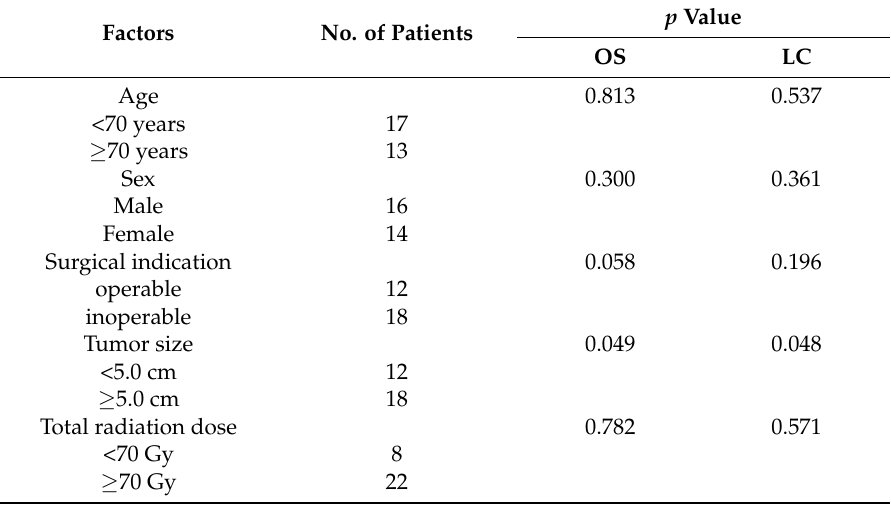
Table 2. Results of log-rank tests for prognostic factors.